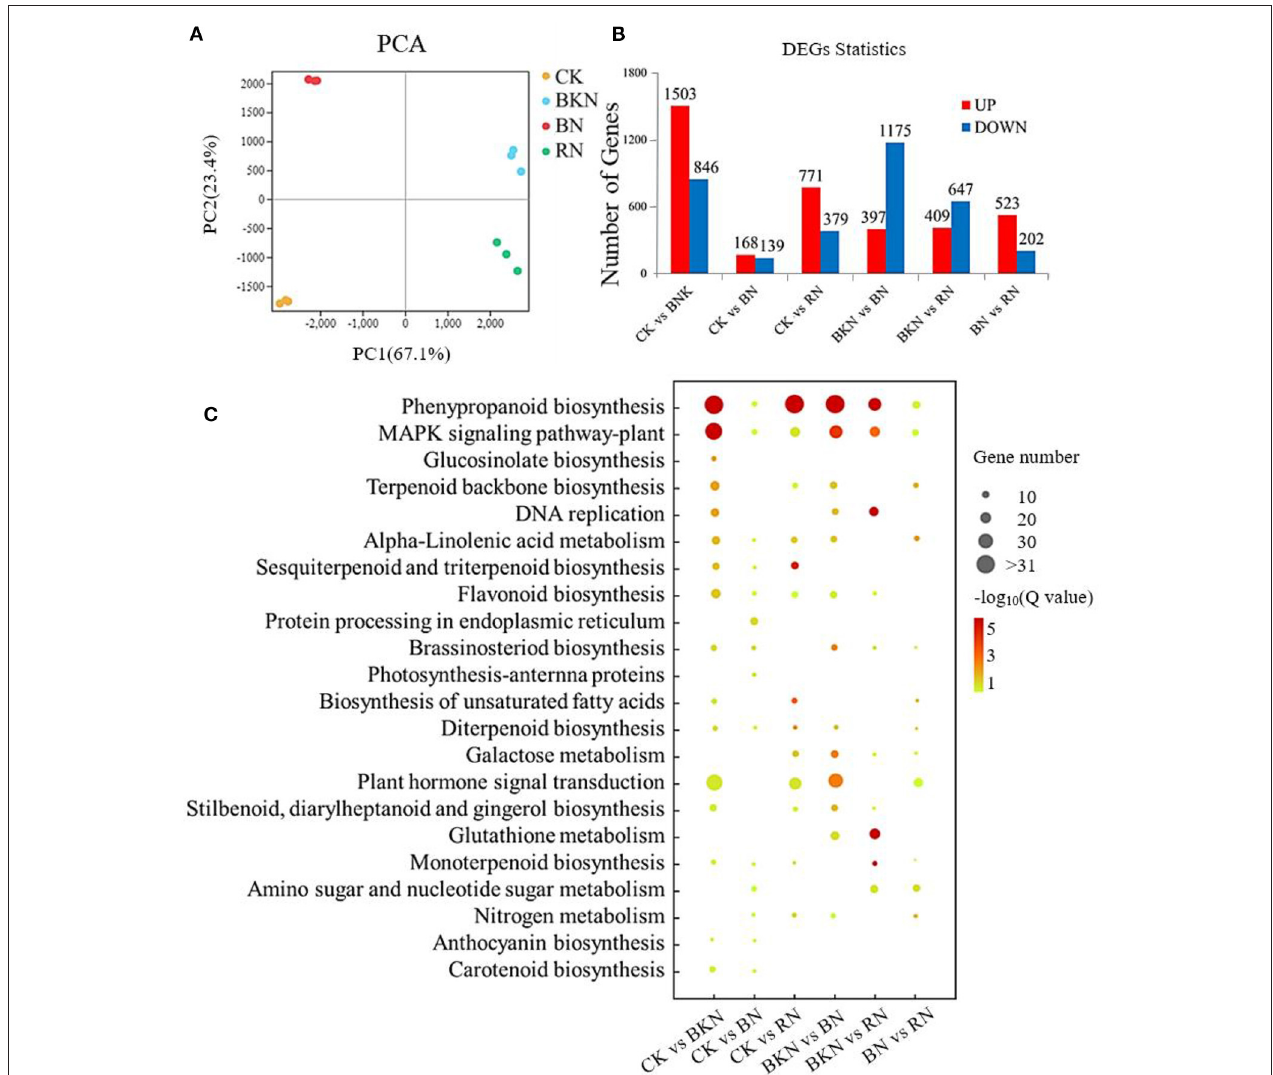
FIGURE 2 | The gene expression profiles of the 2nd tea leaves. (A) PCA analysis; (B) DEG numbers; (C) the enriched KEGG pathways of DEGs. The number of replicates is 3.